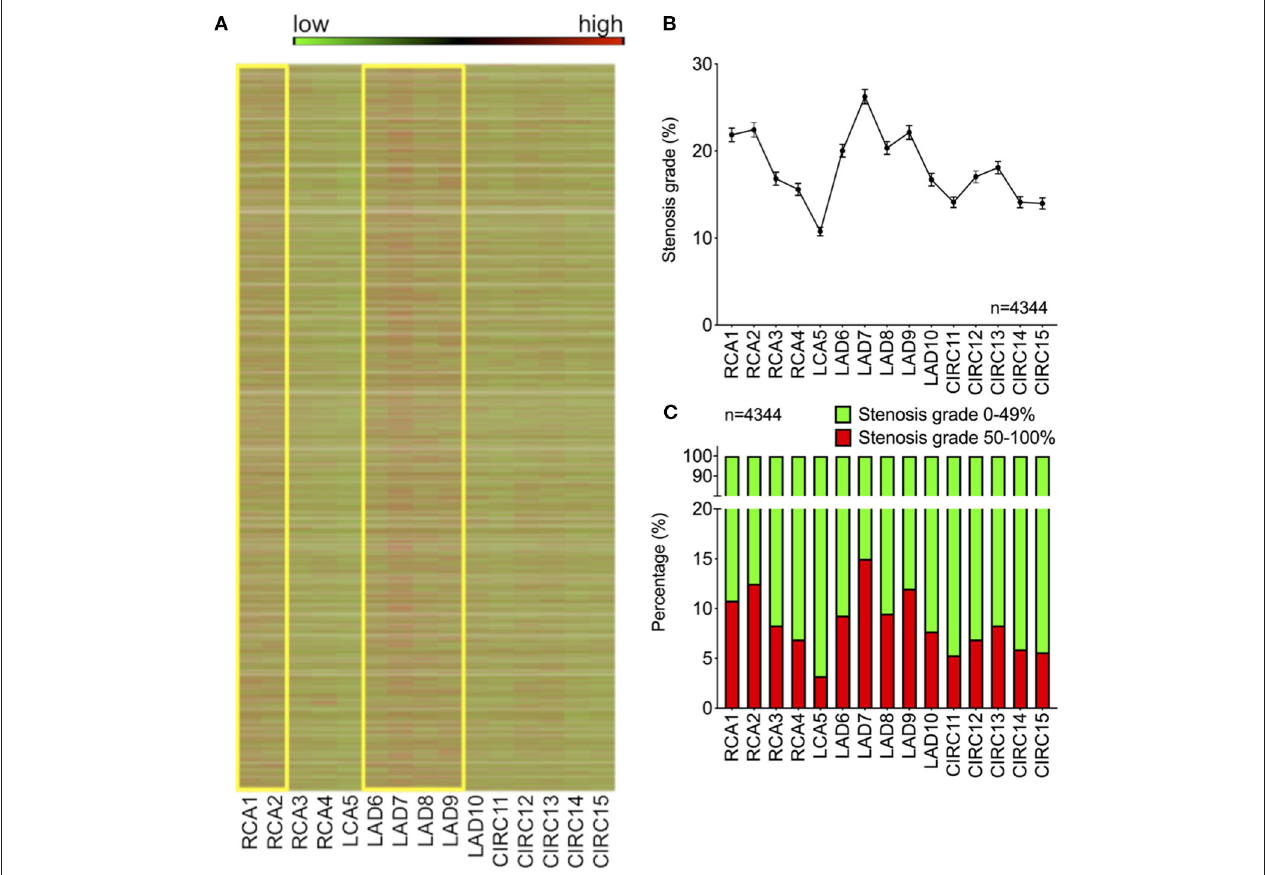
FIGURE 1 | Distribution of plaques among the coronary segments of the Gensini scheme shows specific predilection sites of critical stenosis. (A) Heat map color-coded for degree of stenosis for each patient in the cohort (green = 0%, red = 100%). Yellow boxes indicate proximal LAD and RCA regions. (B) Average stenosis grade across the 15 Gensini segments (shown as mean ± SEM). (C) Percentage of high-grade stenoses > 50% (shown in red) across the 15 Gensini segments (LAD, left anterior descending artery; RCA, right coronary